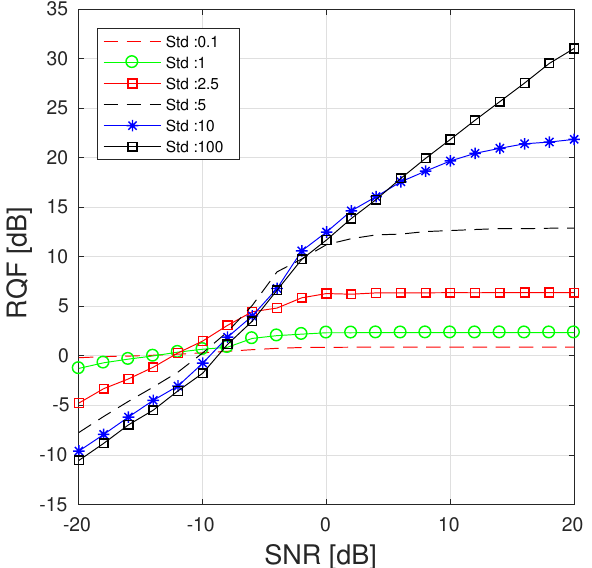
Figure 3. RQFs obtained by using the Gaussian filter approach for various SNR and std for L = 20. The results are averaged over 100 realizations of noise.